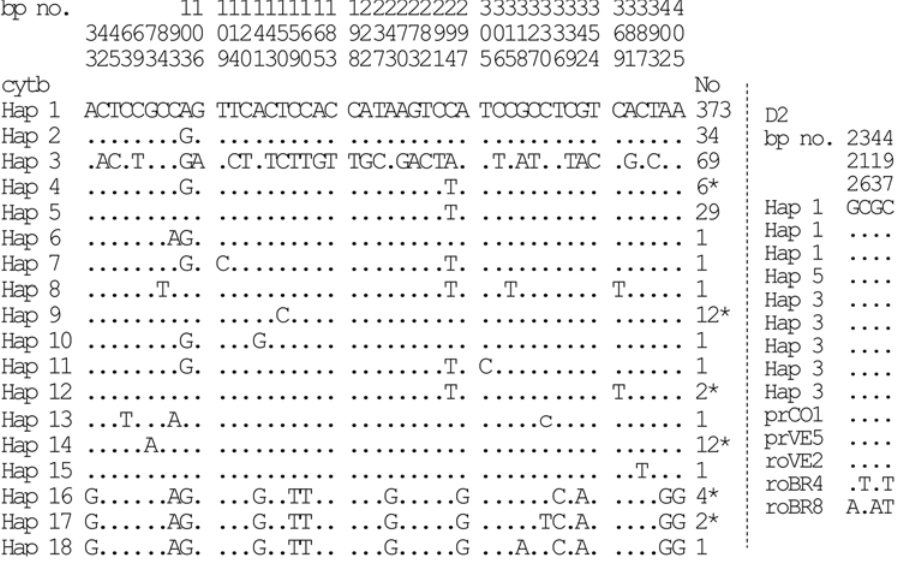
Figure 3. The polymorphic sites of the 18 cytb haplotypes and 9 specimens sequenced for D2.